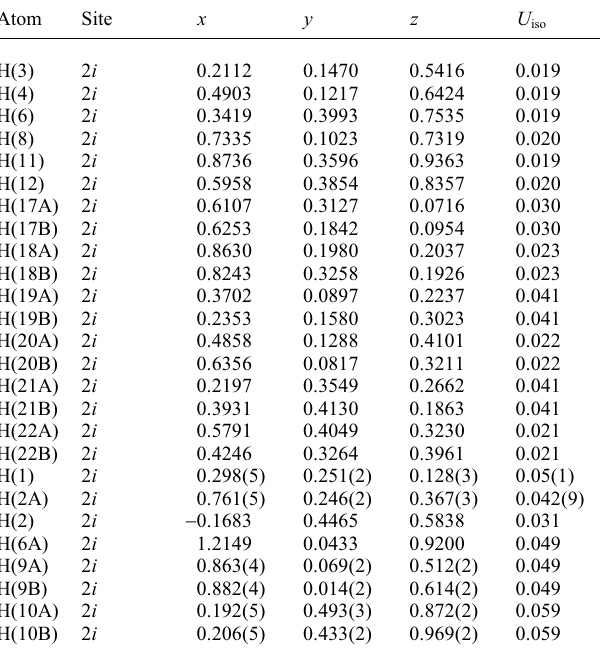
Table 2. Atomic coordinates and displacement parameters (in Å 2 )